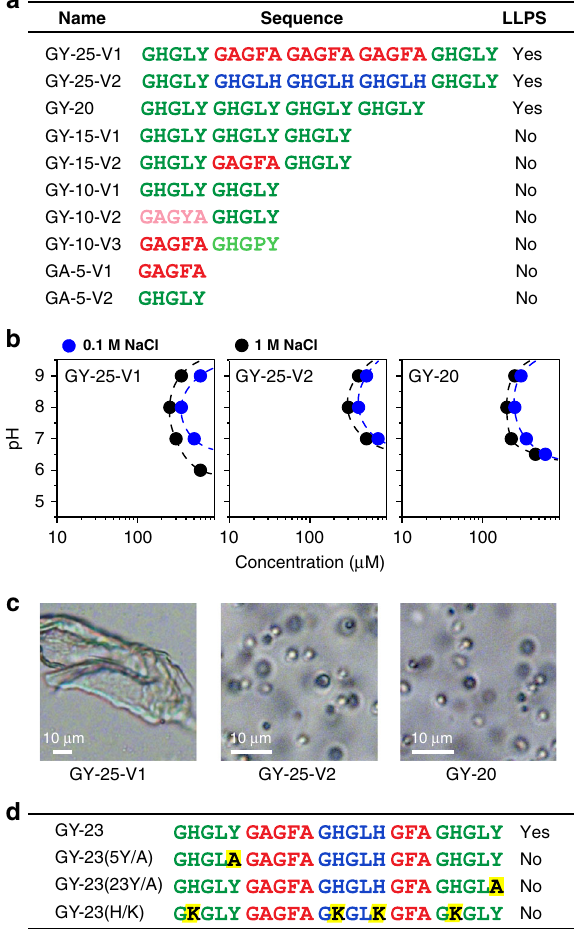
Fig. 3 LLPS properties of HBP-1 and -2 derived peptides. a Sequences and their ability to undergo LLPS. b Phase diagrams of the peptides that exhibited LLPS properties. Source data are provided as a Source Data fi le. c Sample morphology after LLPS by optical microscopy (left micrograph: hydrogel; middle and right micrographs: microdroplets). d Site-directed mutants of GY-23 peptide and their LLPS ability. Color marking of HBP-1 modular repeats is identical to the color-coding described in Fig. 2. All samples were tested in the same conditions in various pH values and salt